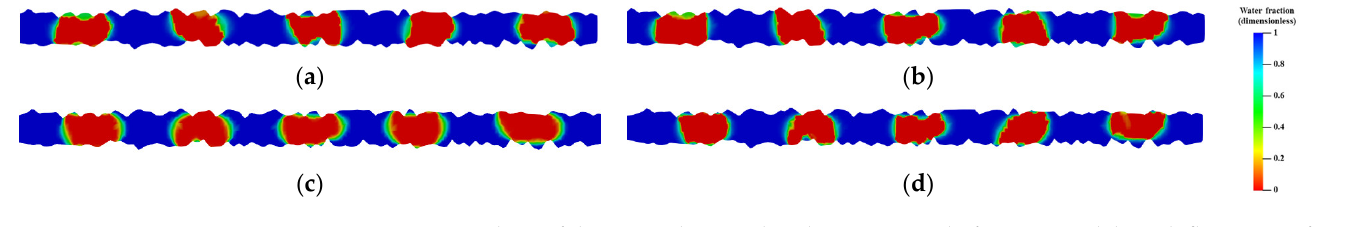
Figure 14. Snapshots of the gas and water distribution in single-fracture models with flow rates of ( a ) 0.0002; ( b ) 0.002; ( c ) 0.004; and ( d ) 0.008 m/s.